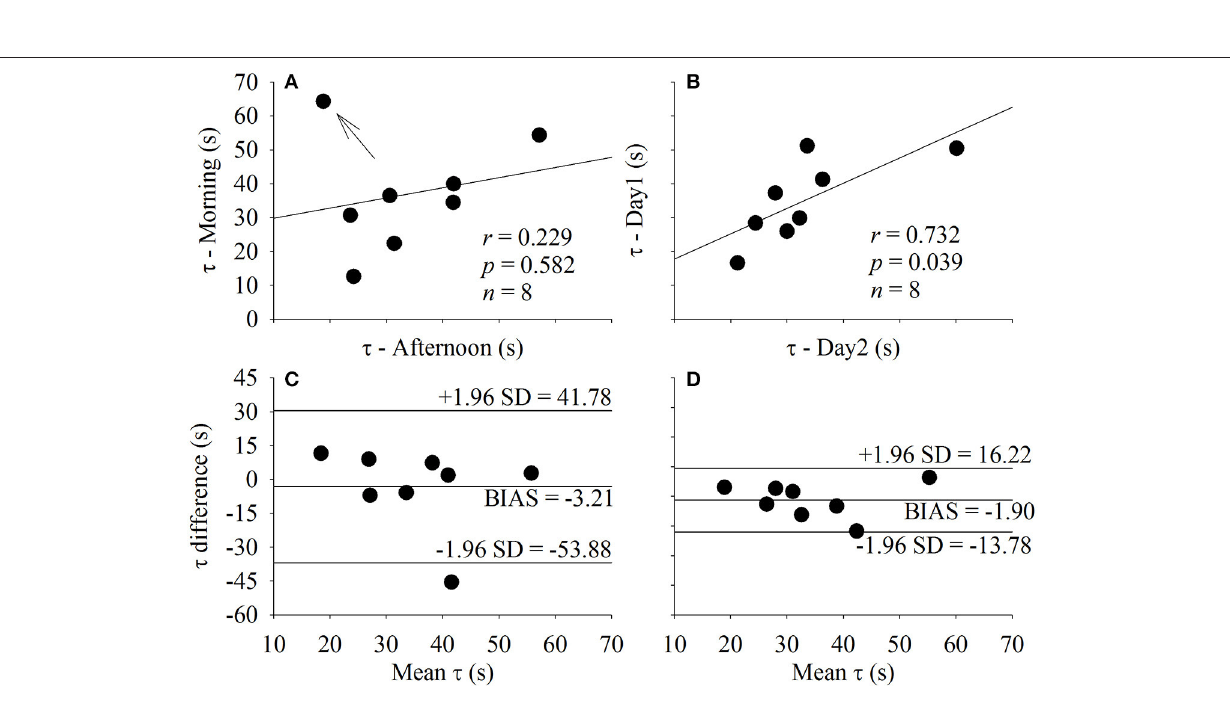
FIGURE 6 | Correlation between the time constant ( τ ) estimated under the influence of different time of the day ( A , Morning vs. Afternoon) and different day of testing ( B , Day 1 vs. Day 2). The agreement level between the factors plotted in (A,B) are displayed in (C,D) , respectively. The arrow indicates an outlier. r , Pearson’s correlation level; p , statistical significance level; n , sample